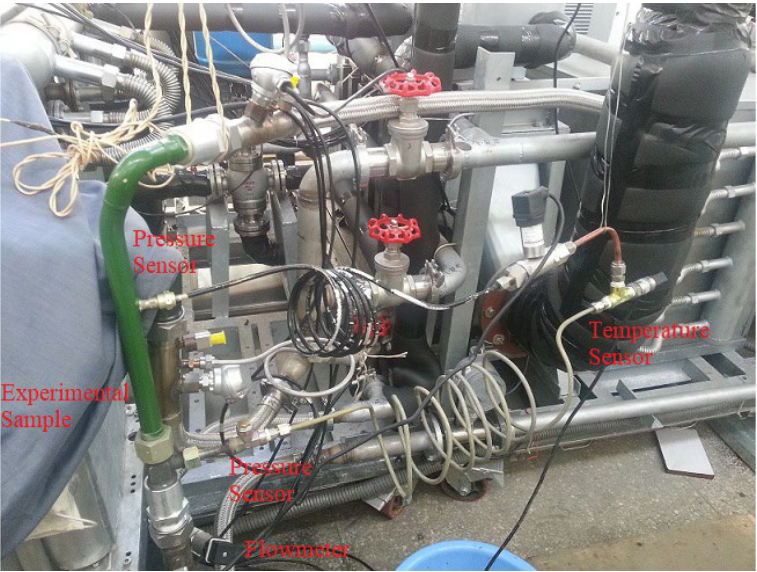
Figure 2. Schematic diagram of the aircraft liquid cooling system.